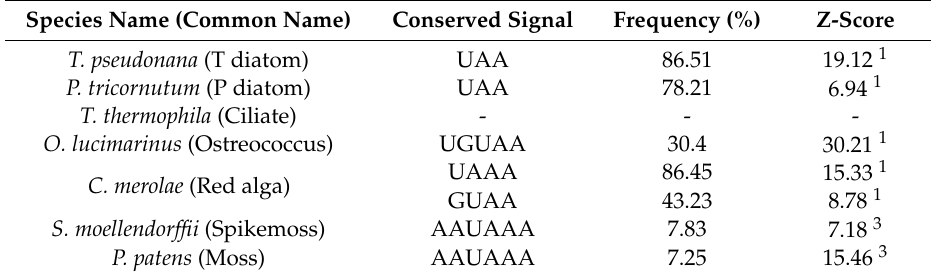
Table 1. The conserved poly(A) signals in the near upstream element (NUE) region of the seven species. Species Name (Common Name) Conserved